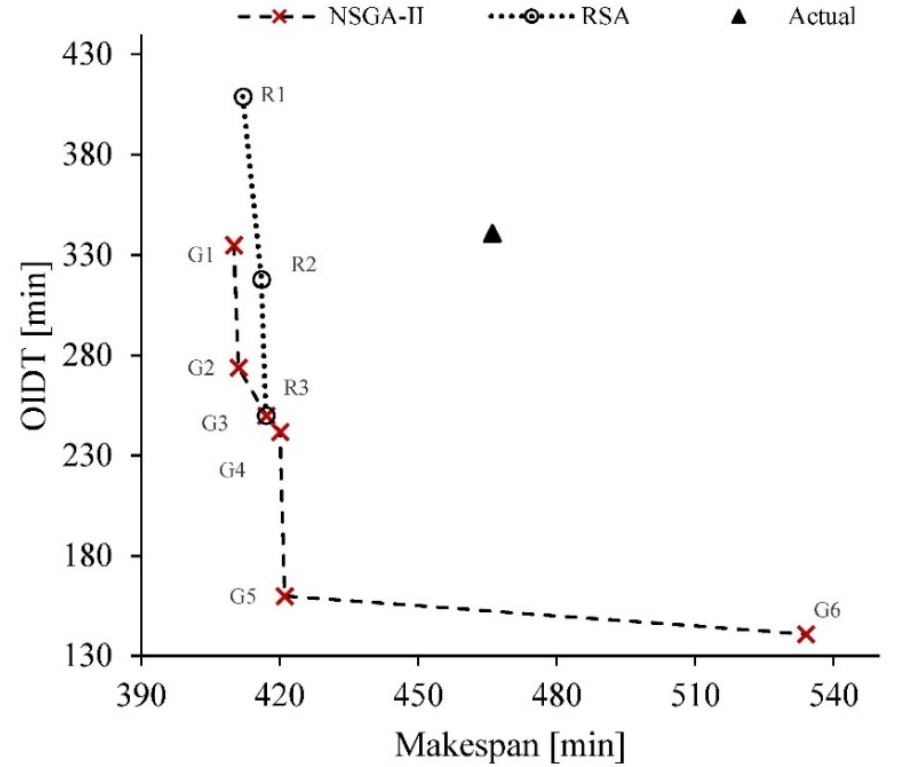
Figure 14. The solutions found by NSGA-II and RSA for BMP-III.